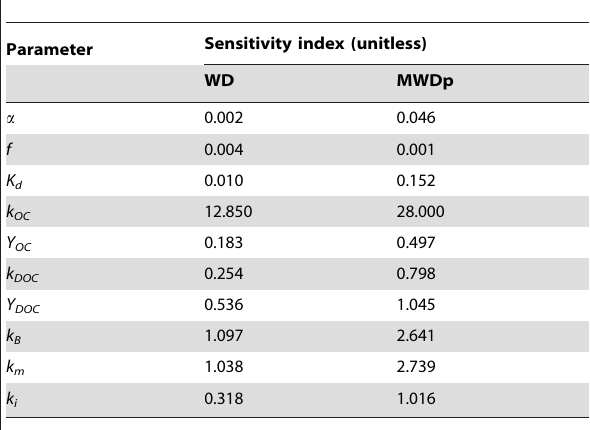
Table 2. Sensitivity indices for model parameters 1